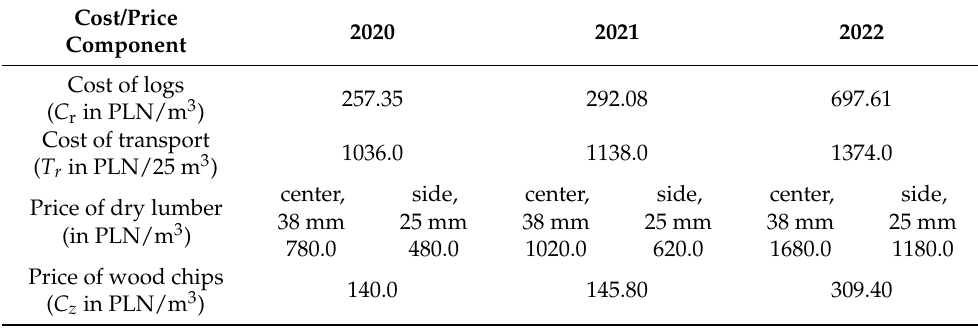
Table 1. List of average annual prices for the processing of logs into lumber.